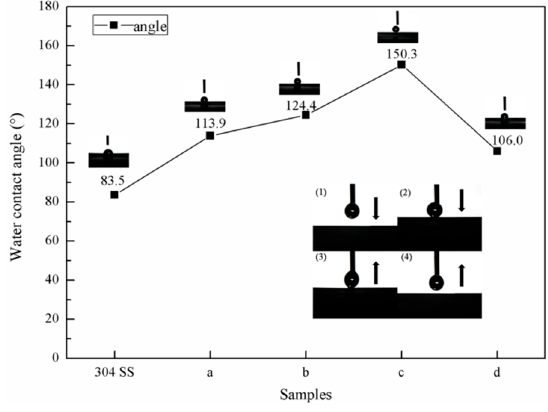
Figure 6. Static contact angle on the sample surface.